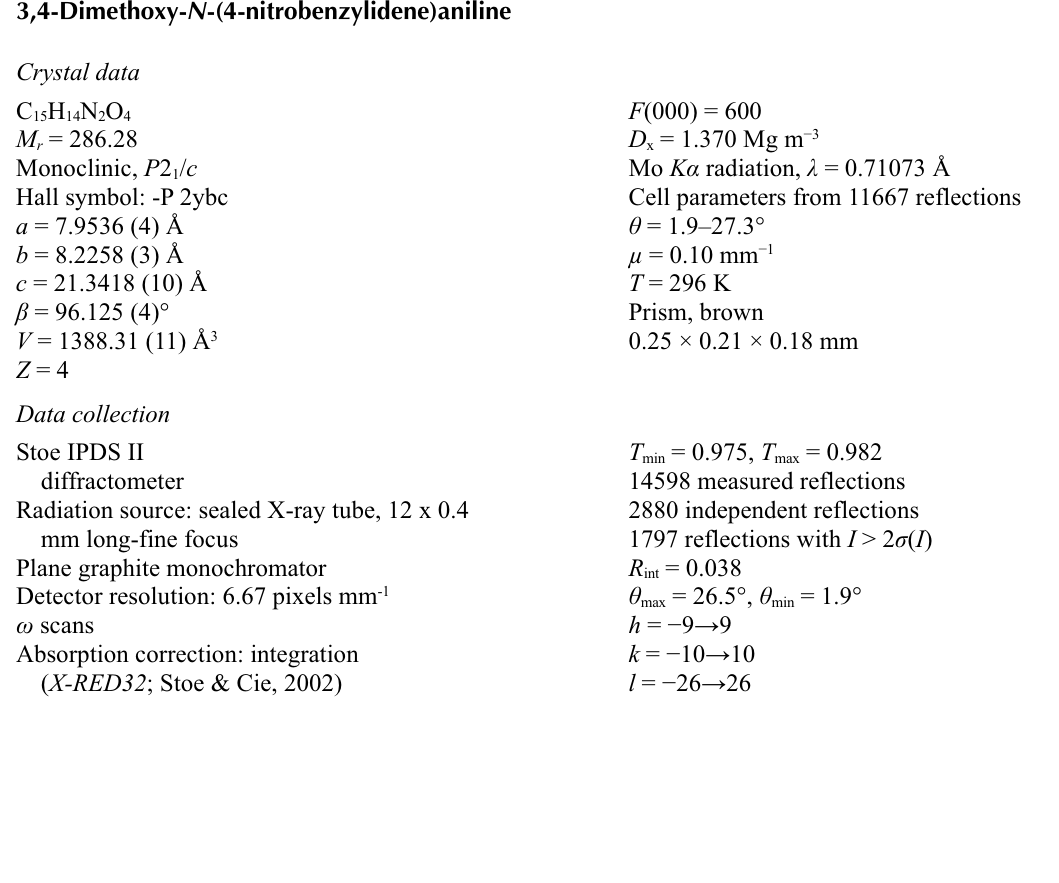
Figure 2 View down the b axis of the packing and C—H···O contacts in the unit cell of (I). H atoms not involved in C—H···O contacts (dashed lines) have been omitted for